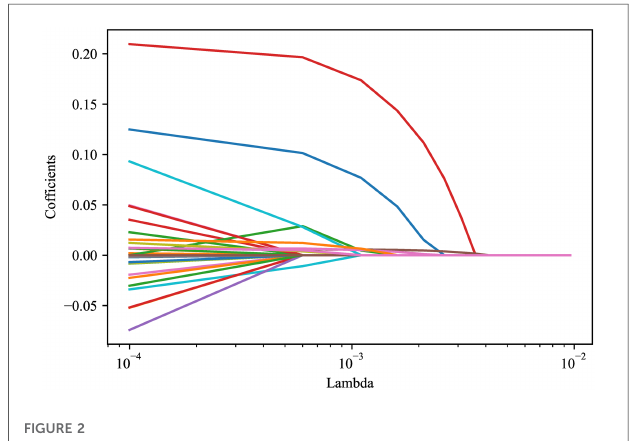
FIGURE 2 LASSO regression analysis screening the predictors for in-hospital mortality of metastasitc cancer patients.